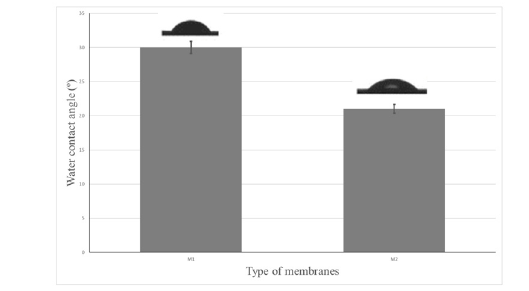
Figure 4. Contact angle of